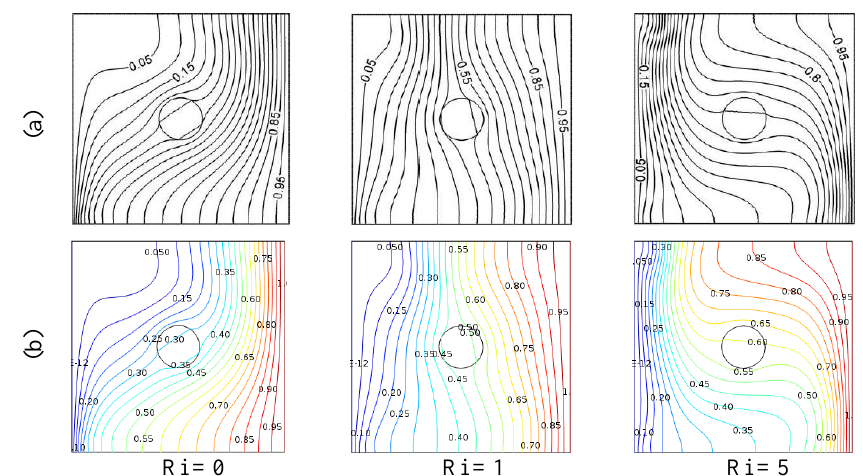
Fig. 3. Isotherms in the cavity for different Richardson numbers, with a Hartmann number Ha = 10 (a) Rahman et al. 2010 (b) present